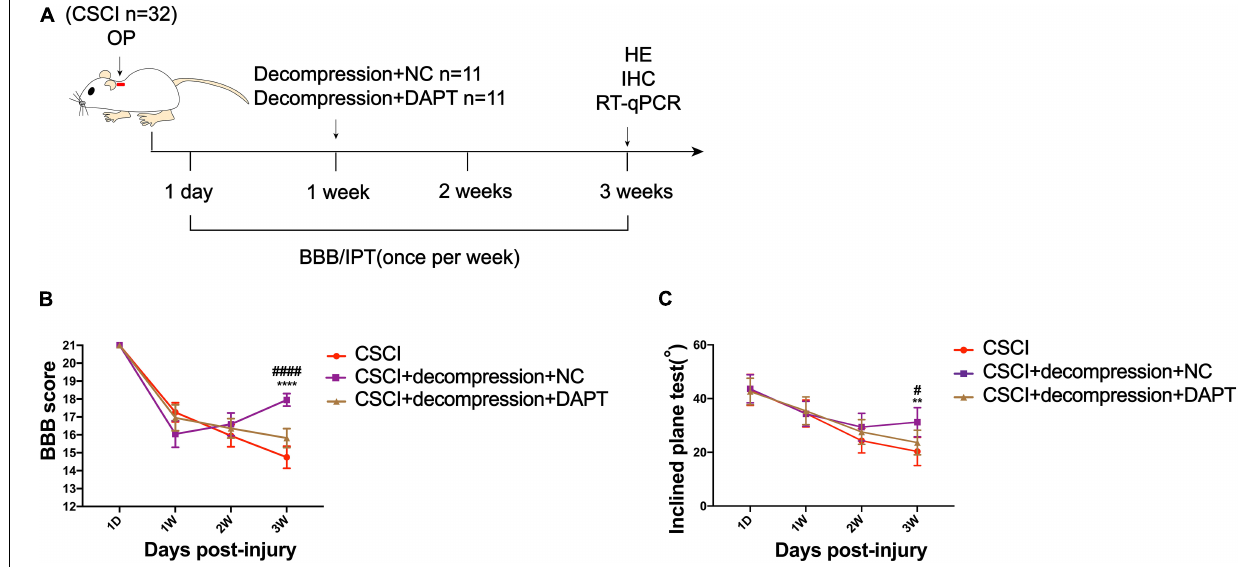
FIGURE 6 | Inhibition of Notch-1 attenuated motor function recovery after decompression. (A) Experimental design. (B) Animals were tested weekly starting from 1 dpi in an open field, and motor function recovery was evaluated according to the BBB score [Two-way ANOVA, F (6,116) = 16.85, p < 0.0001; **** p < 0.0001: CSCI group vs. CSCI with decompression and NC group; #### p < 0.0001: CSCI with decompression and NC group vs. CSCI with decompression and DAPT group]. (C) Animals were tested weekly starting from 1 dpi using the IPT, and the angle ( ◦ ) was recorded to reveal the motor function recovery [Two-way ANOVA, F (6,116) = 3.279, p = 0.0412; ** p = 0.0052: CSCI group vs. CSCI with decompression and NC group; # p = 0.0431: CSCI with decompression and NC group vs. CSCI with decompression and DAPT group]. The CSCI group: n = 10; CSCI with decompression and NC group: n = 11; CSCI with decompression and DAPT group: n = 11. Mean ± 95%